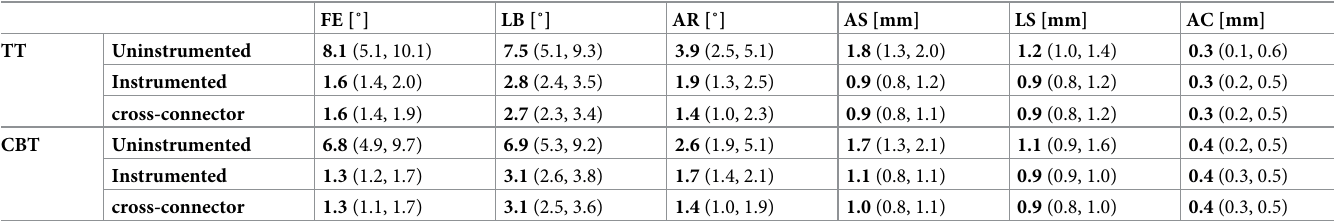
Table 2. Recorded range of motion.